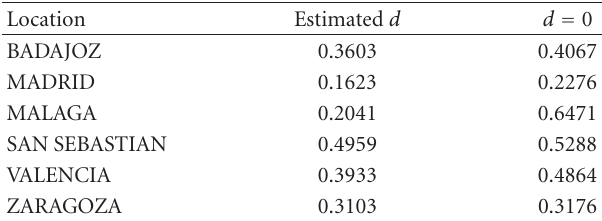
Table 6: Annual increase in the temperatures (in 0.1 ◦ C). Series: T min .